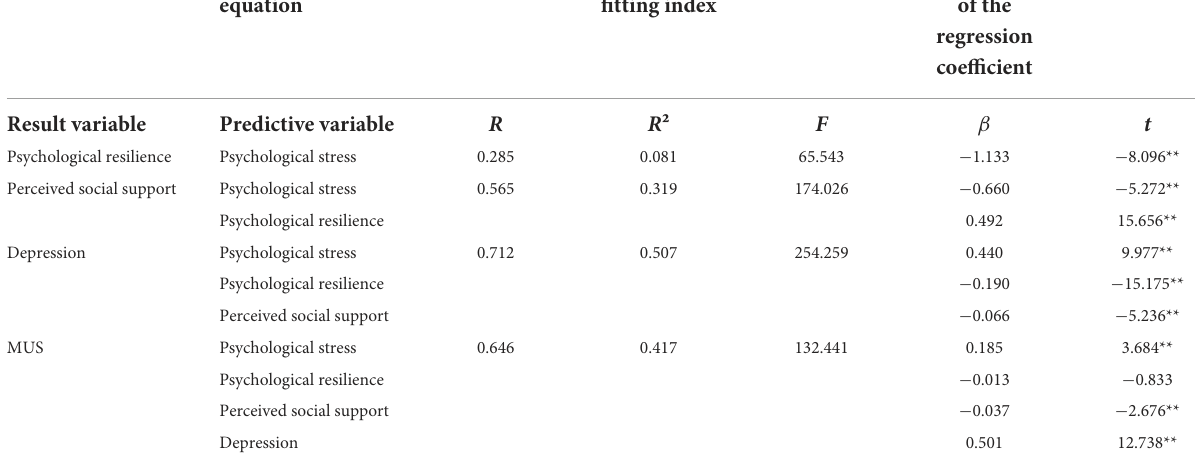
TABLE 4 Regression analysis between